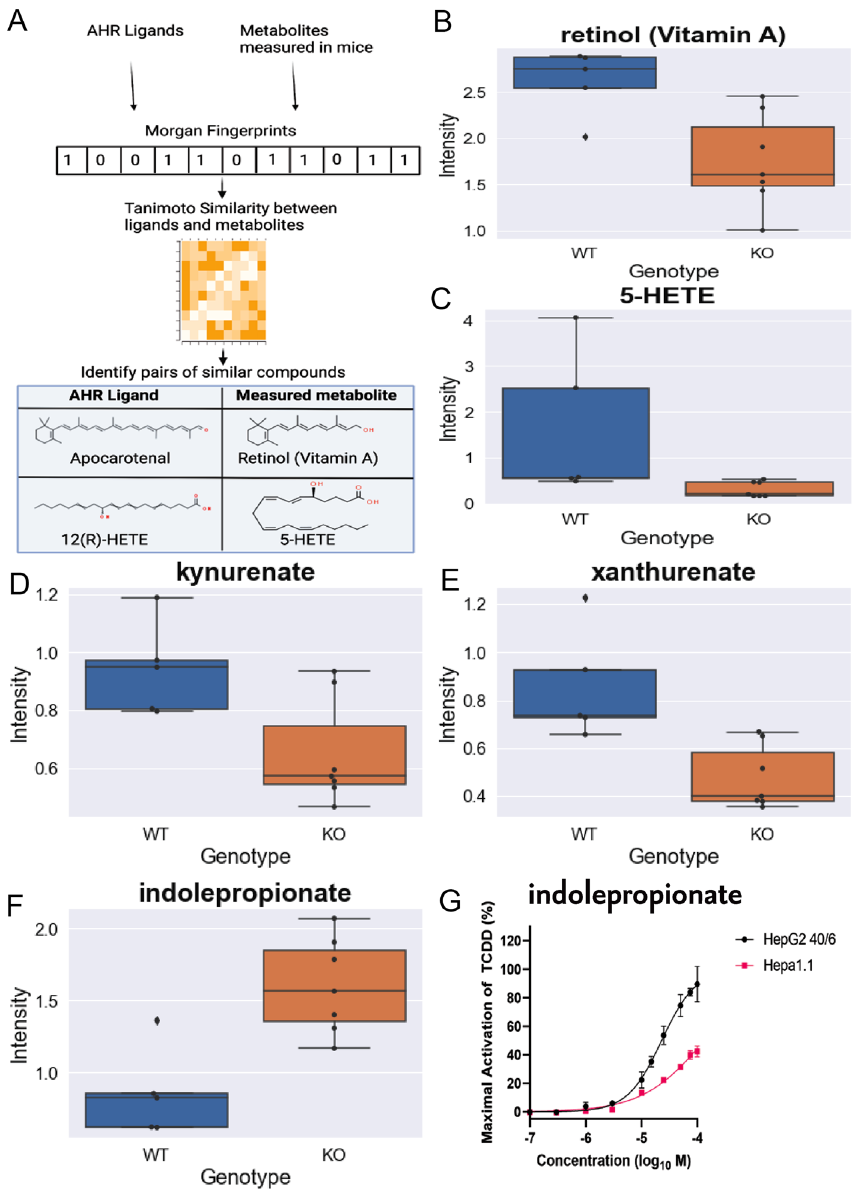
Figure 5. Five AHR ligands or compounds chemically similar to ligands are significantly altered in the serum of Ahr −/− mice (n = 7) compared to Ahr +/+ mice (n = 5). ( A ) Known AHR ligands were chemically compared to the measured metabolites using Tanimoto index to identify similar compounds. Five of the 25 measured AHR ligands and structurally related metabolites were among the 290 significantly altered metabolites. ( B ) Retinol (Vitamin A), structurally similar to apocaretanol was significantly decreased in the serum. ( C ) 5-HETE, similar to the AHR ligand 12(R)-HETE, was significantly decreased in the serum. ( D ) Kynurenate was significantly decreased in the serum. ( E ) Xanthurenate was significantly decreased in the serum. ( F ) Indolepropionate was the only AHR ligand that was elevated in the serum. Box plots include the median (central line), lower quartile (lower limit of box), upper quartile (upper limit of box), max value (upper limit of whisker), and minimum value (lower limit of whisker). Each metabolite in this set is represented by an individual point. ( G ) Indole-3-propionic acid was assessed for its ability to activate both human and murine AHR at ten biologically relevant doses (100 nM, 300 nM, 1, 3, 10, 15, 25, 50, 75, 100 μM final concentrations). TCDD (10 nM final concentration) was used to determine maximal activation of AHR, and the presented values were normalized as a percentage of TCDD activation. Each data point represents the mean ± S.D. of three biological